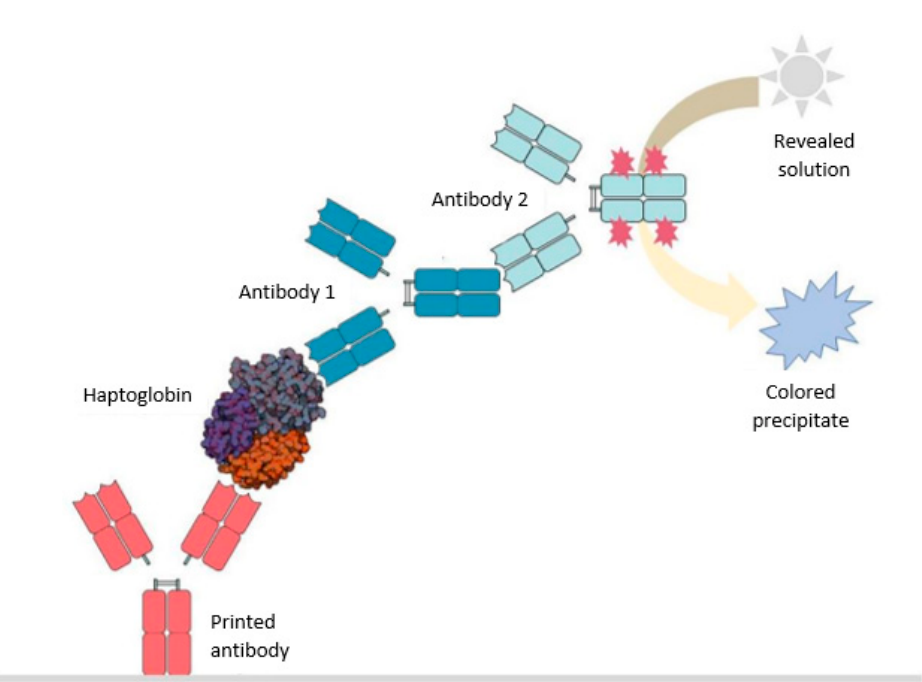
Figure 6. Scheme of haptoglobin detection through the immunoassay developed in house at IMG Pharma Biotech S.L. for its use in fresh milk.